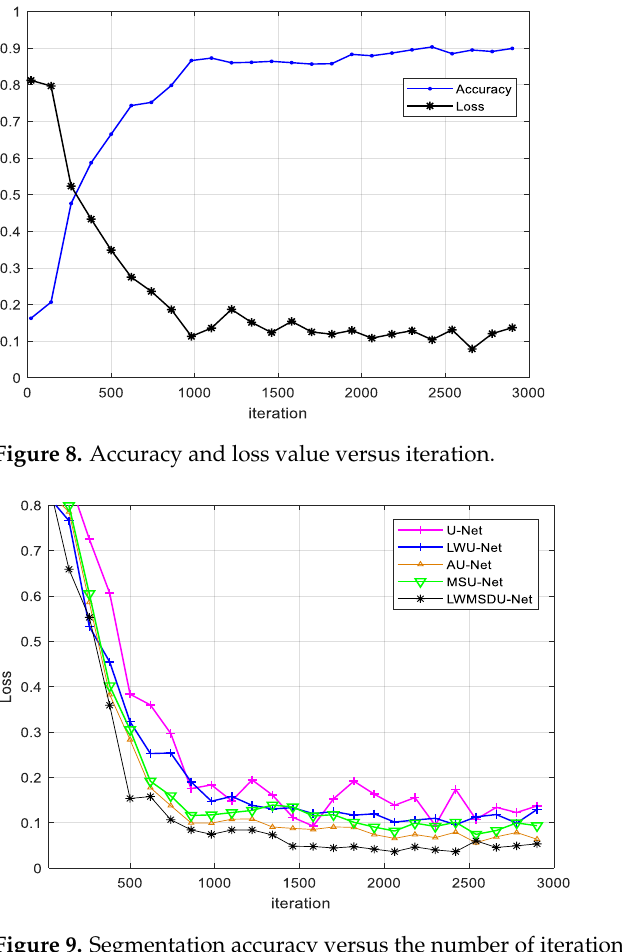
Table 2. Segmentation results of U-Net, LWU-Net, AU-Net, MSU-Net and